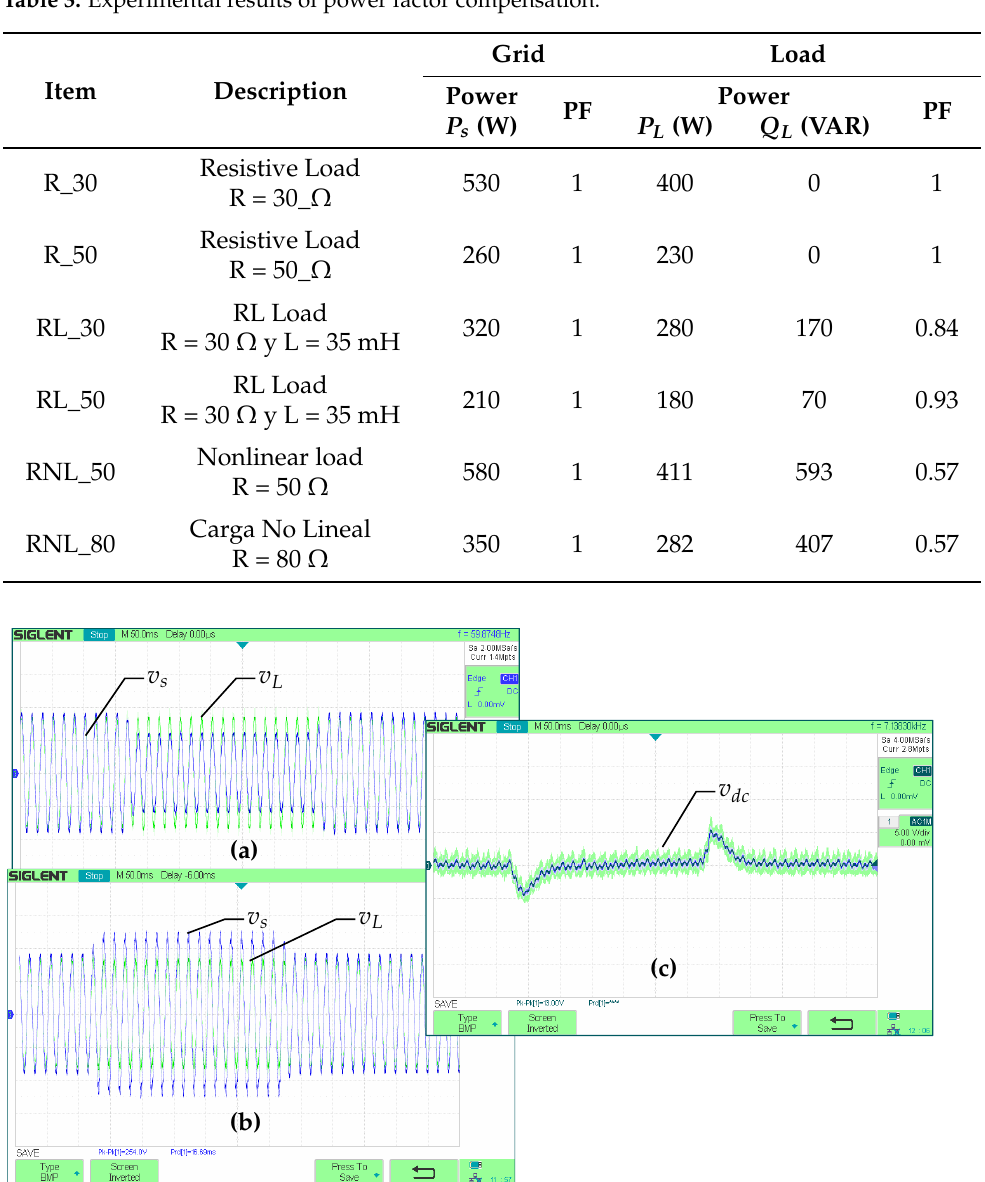
Table 3. Experimental results of power factor compensation.